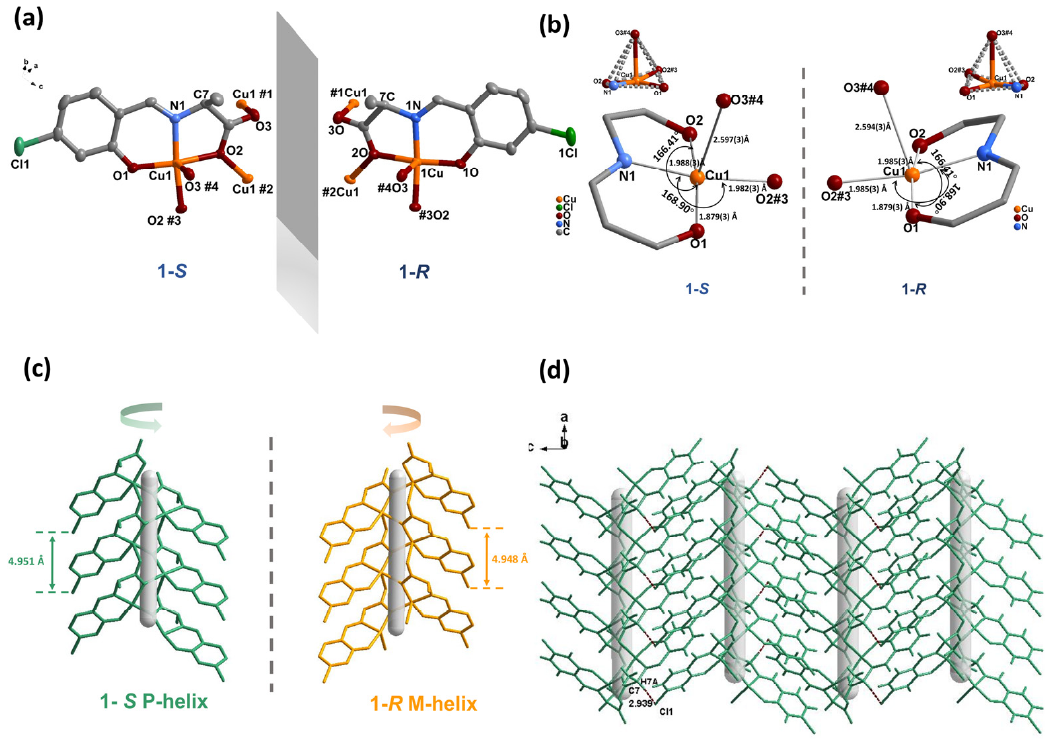
Figure 1. ( a ) Coordination environment presentation of 1- S and 1- R with 50% thermal ellipsoid probability (hydrogen atoms have been omitted for clarity); symmetry mode: #1:1/2 + x,1/2 − y, − z; #2: x, − 1 + y, − 1 + z; #3: − 1 + x, − 1 + y, − 1 + z; #4: − 3/2 + x, 1/2 − y, − z; ( b ) bond lengths and largest angles around the Cu(II) ion; ( c ) helical structures were formed via Cu1-O2-Cu1-O2 coordination